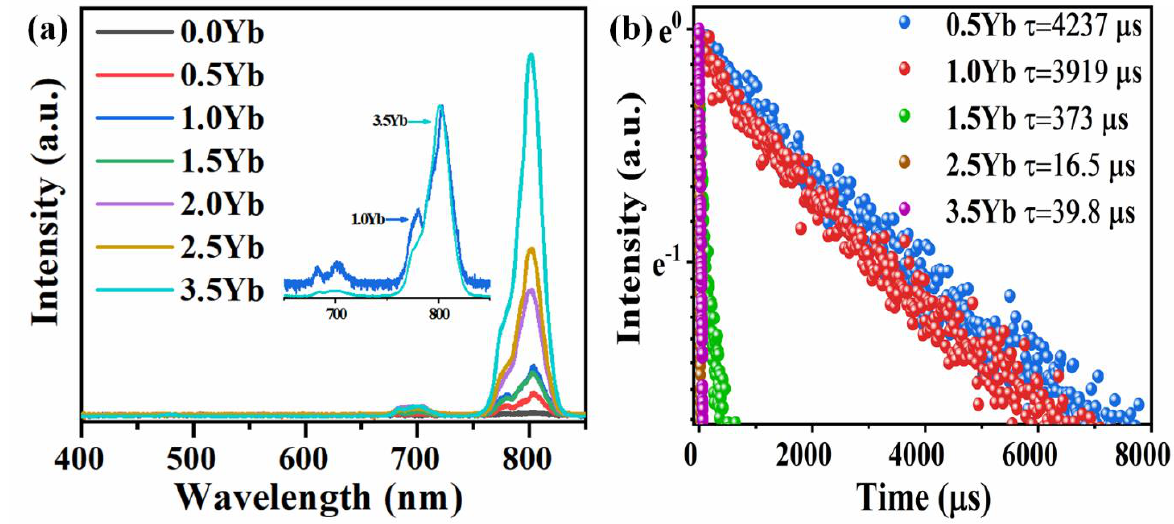
Figure 6. ( a ) UC emission spectra x Yb 3+ -0.1Tm 3+ co-doped GCs heat treated at 540 °C for 5 h. ( x = 0.0~3.5). ( b ) Emission decay curves of x Yb 3+ -0.1Tm 3+ co-doped PG and GCs heat treated at 540 °C for 5 h monitored at 802 nm emission. ( x = 0.5~3.5).